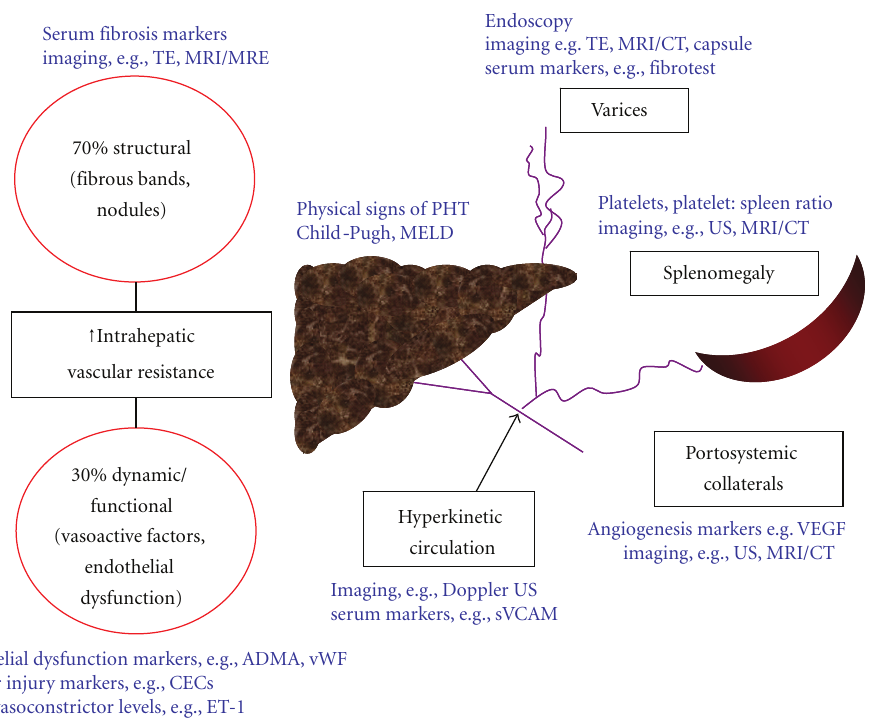
Figure 2: Schematic representation of the pathophysiology of portal hypertension with corresponding potential noninvasive markers. TE: transient elastography; MRI(E): magnetic resonance imaging (elastography); US: ultrasound; CECs: circulating endothelial cells; ADMA: asymmetric dimethylarginine; vWF: von Willebrand factor; ET-1: endothelin-1; MELD: Model for End-Stage Liver